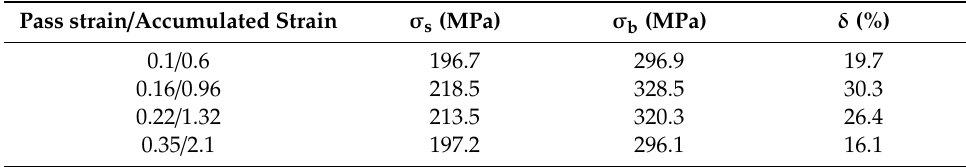
Figure 8. Mechanical properties of AZ31 alloys HSRMFed to 6 pass with different pass strains and accumulated strains. Table 1. Mechanical properties of AZ31 alloy HSRMFed 6 pass with di ff erent pass strains and Table 1. Mechanical properties of AZ31 alloy HSRMFed 6 pass with different pass strains and accumulated accumulated strains.